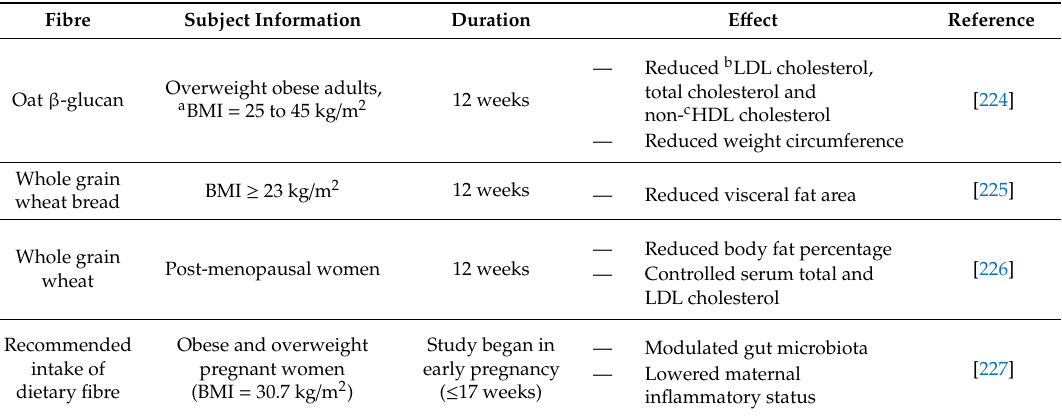
Table 4. Impact of fibre on overnutrition in human intervention